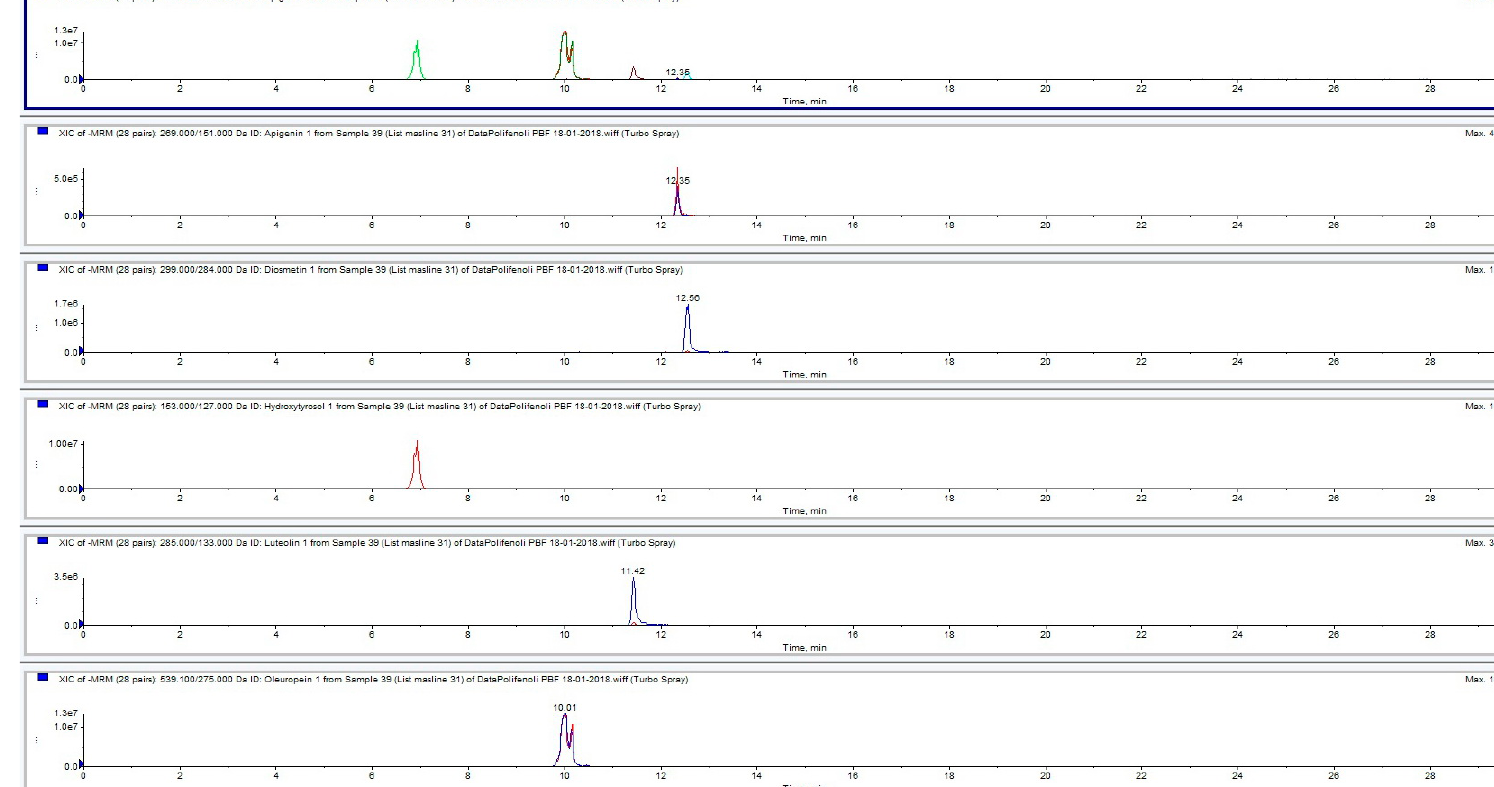
Figure 4. ( a ) UPLC-MS/MS analysis chromatogram of HVED treated (with argon) OLE (OLA1)—total ion current (TIC). ( b ) UPLC-MS/MS analysis chromatogram of HVED treated (with argon) OLE (OLA1) .